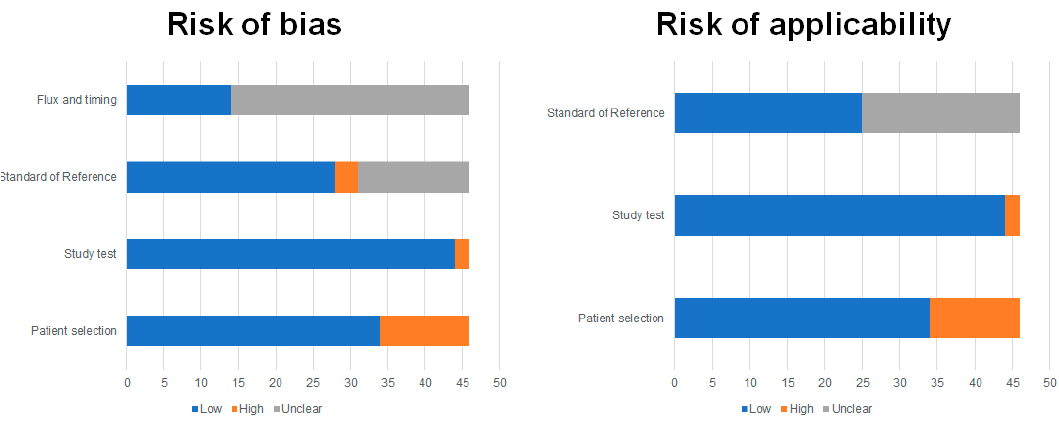
Figure 2. Study quality assessment. Overall quality assessment of the studies included in the systematic review according to the revised quality assessment of diagnostic accuracy studies (QUADAS-2) tool